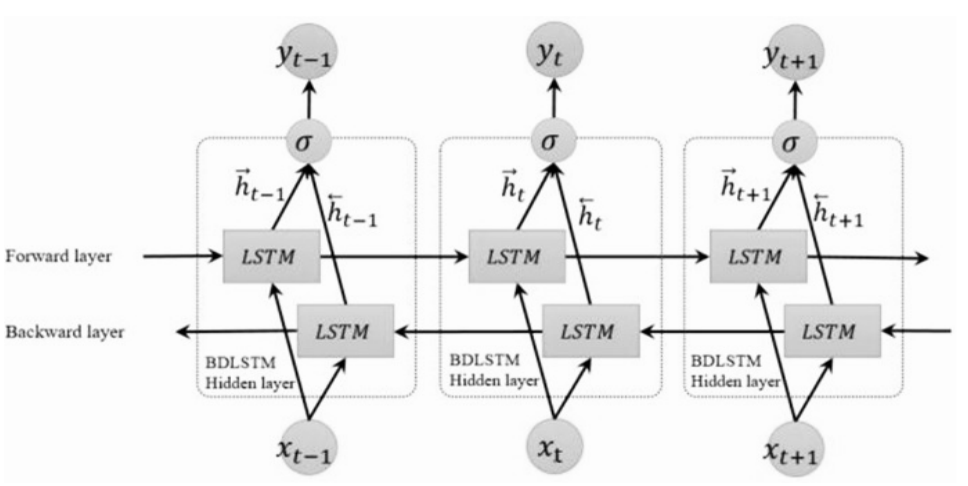
Figure 6. Bidirectional long-short-term memory layer with both forward and backward LSTM layers. Is illustrated in Figure